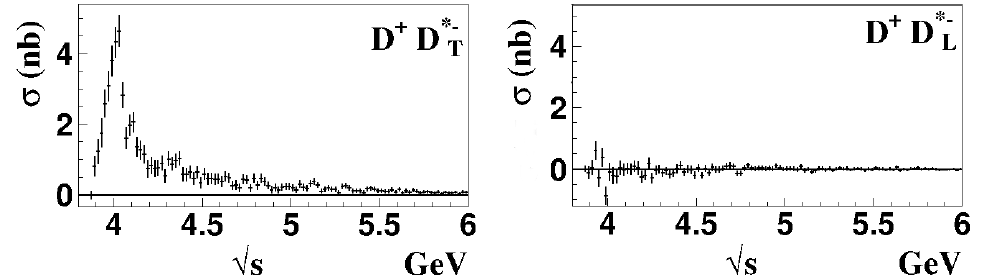
Figure 2. The exclusive cross sections as functions of √ s for e + e − (right). The insets show the zoomed spectrum near the threshold with a half-size bin width.